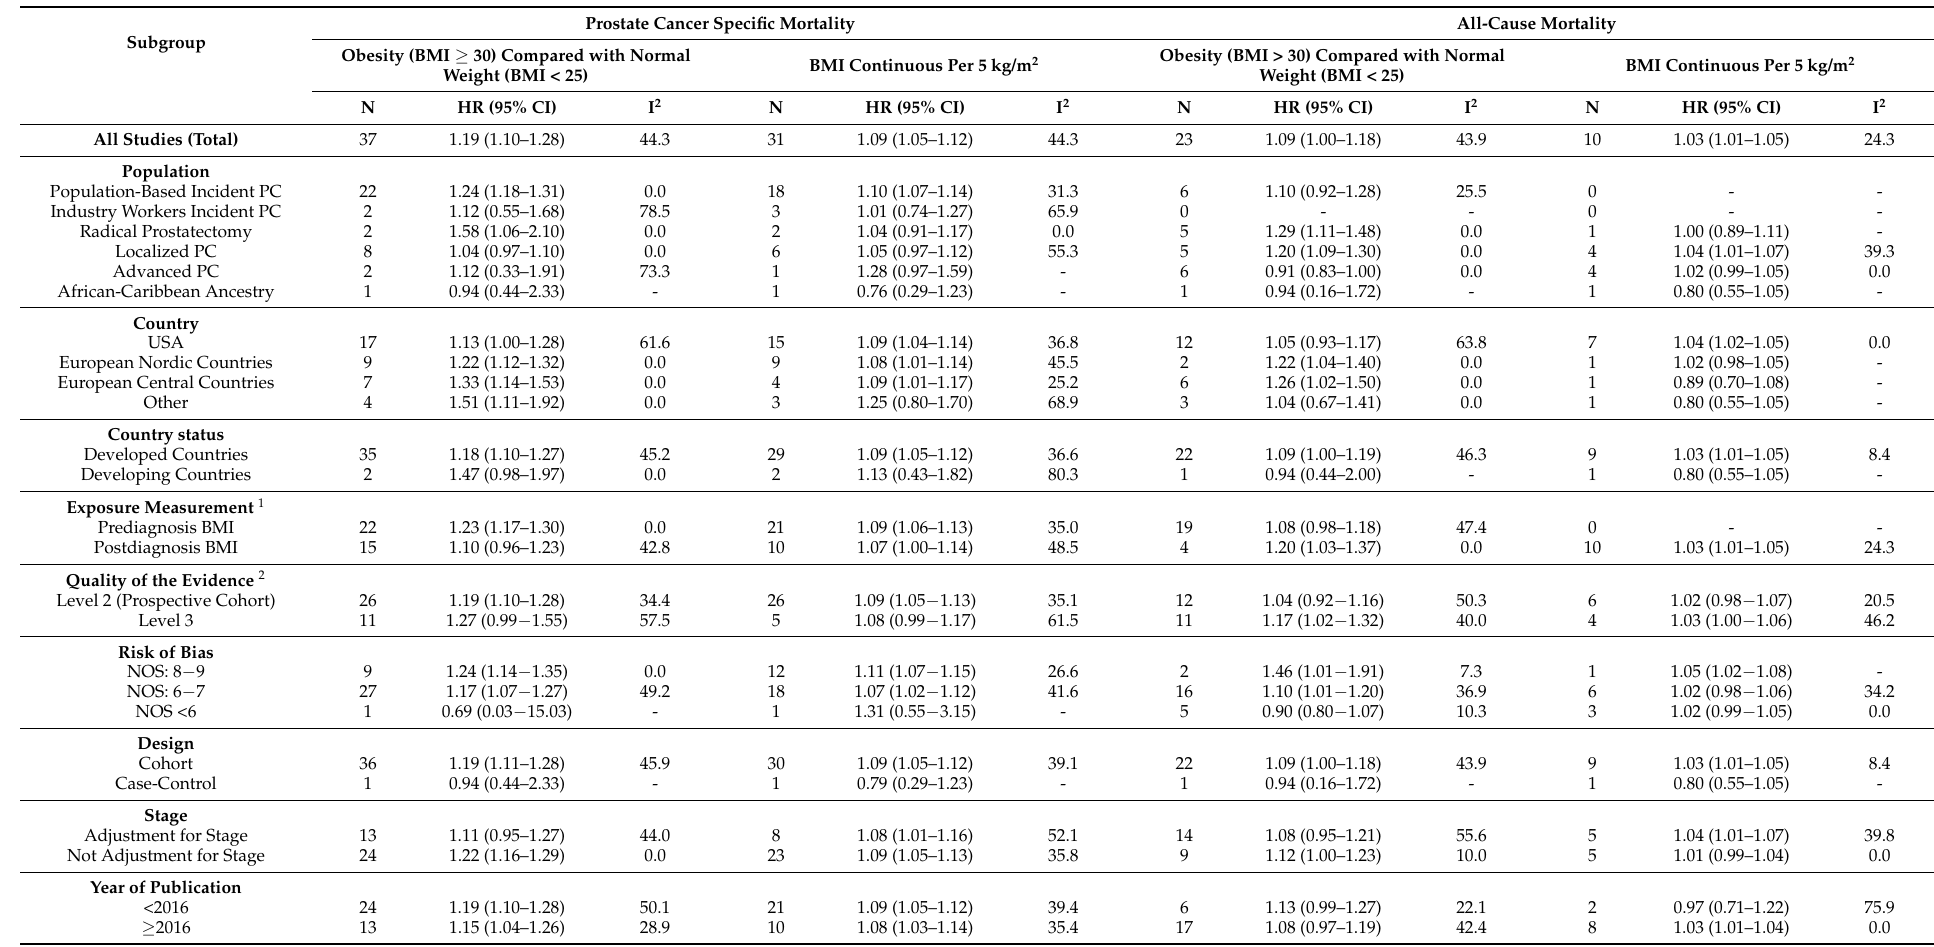
Table 1. Subgroup analysis of the pooled association of body mass index with prostate cancer specific mortality and all-cause